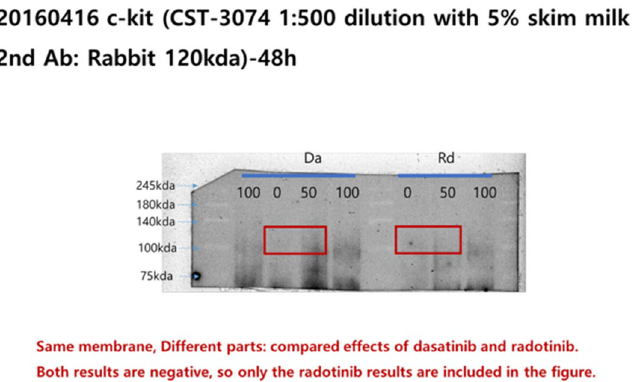
Figure 4. Original image of the membranes showing Radotinib/c-kit, corresponding to Fig 6B.